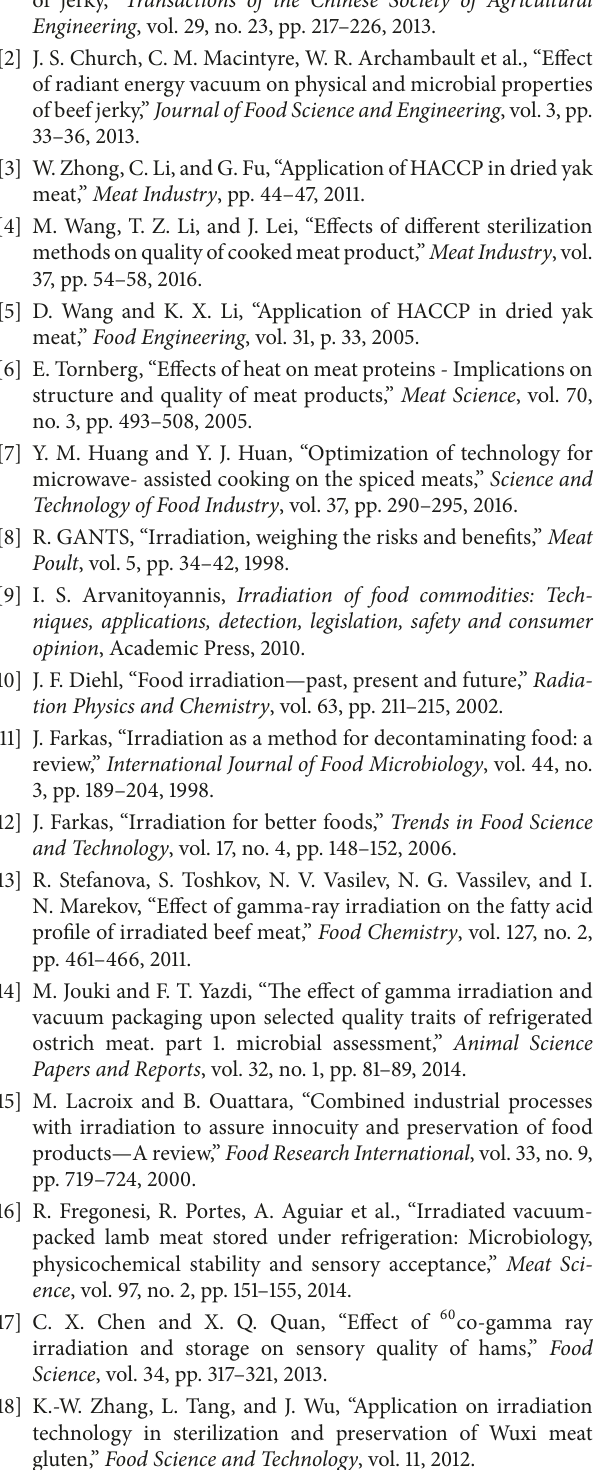
Table 1: Plate counts of aerobic bacteria and Escherichia coli in the SBJ after irradiation. Irradiation dose (kGy) Counts of Escherichia coli